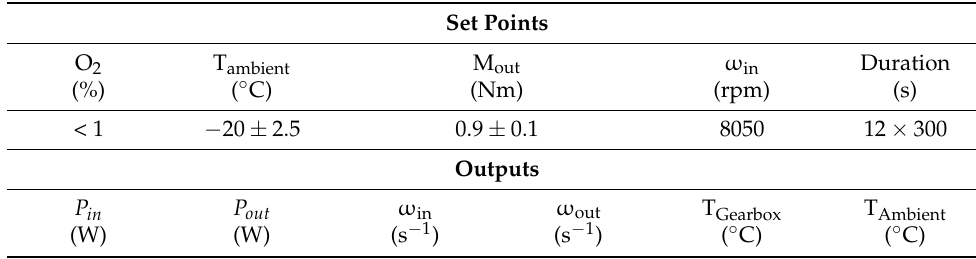
Table 3. Test rig set points and